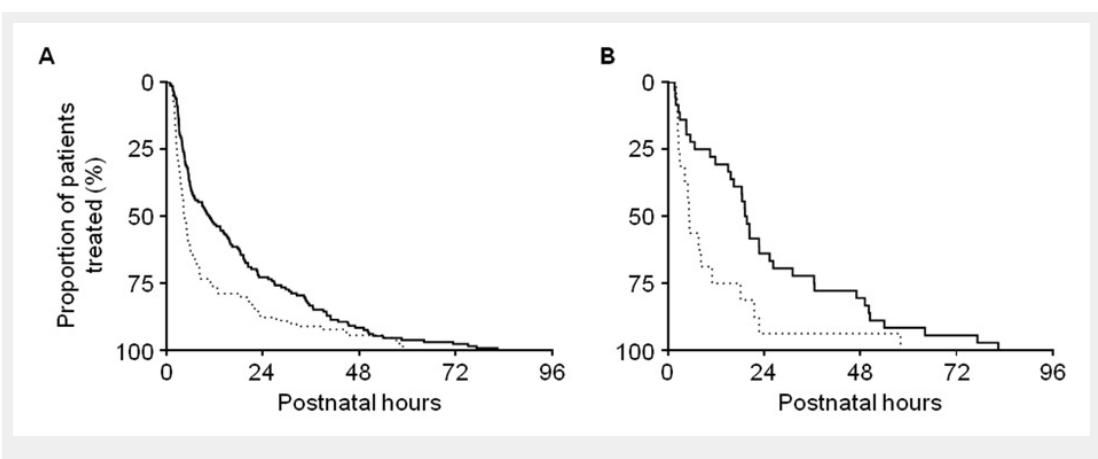
Kaplan-Meier estimates of the time between birth and the first dose of antibiotics in: (A) all infants treated for suspected early-onset neonatal sepsis during Period 1 (full line, n = 132) and Period 2 (dotted line, n = 90), p <0.001; (B) infants with neonatal infection during Period 1 (full line, n = 36) and Period 2 (dotted line, n = 16), p